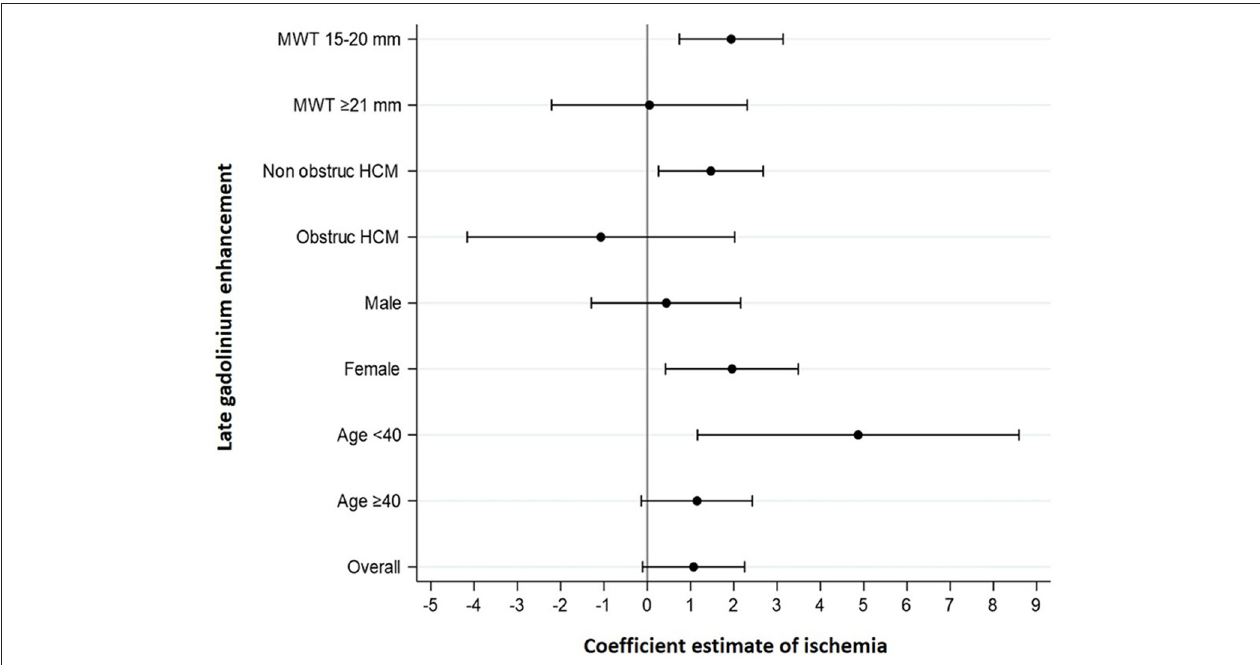
FIGURE 3 | Forest plots for the association between ischemia and LGE. The severity of ischemia was associated with the extent of LGE in patients with MWT 15–20mm, nonobstructive HCM, women, and age < 40 years. Coefficients’ estimates and corresponding 95% confidence intervals were obtained by multivariable linear regression models for LGE. MWT, maximum wall thickness; obstruct HCM, obstructive hypertrophic